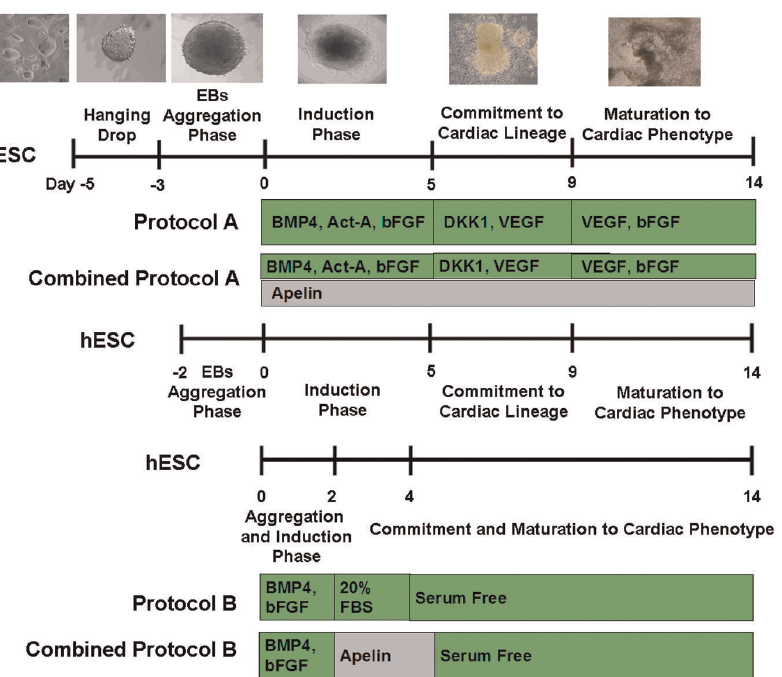
Figure 1. Timeline. Our combined protocols for both mESCs and hESCs include the addition of apelin (grey) to the reported protocols (green). Protocols A and B are indicated in the green boxes without apelin treatment.